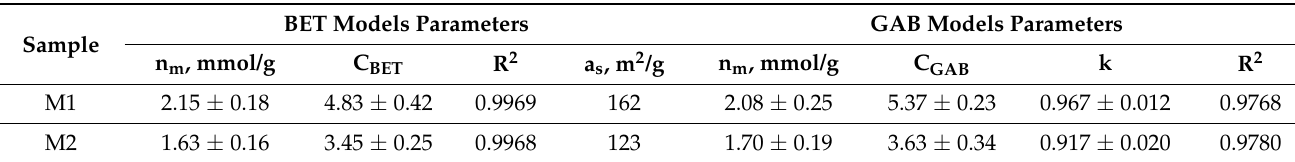
Table 1. Calculated BET and GAB model parameters for muffins.